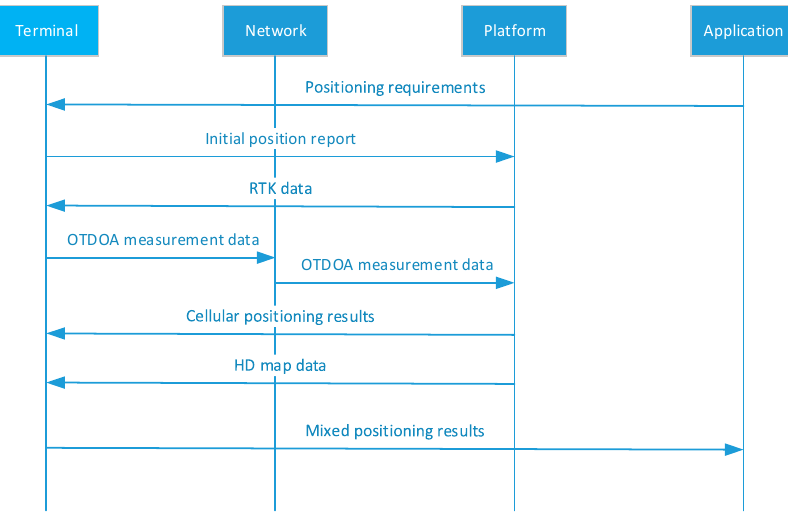
Figure 5. Signaling processing in the UE-based positioning architecture.